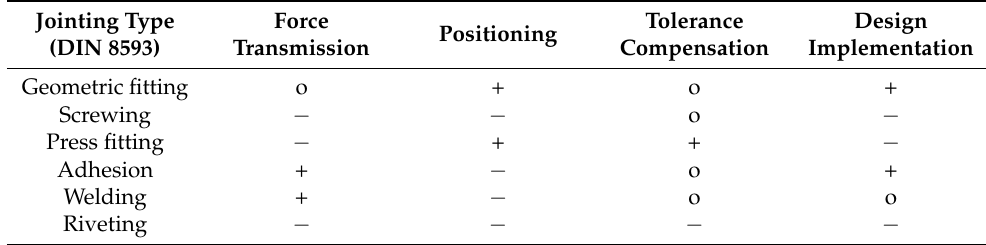
Table 2. Evaluation of different joint types in terms of the given task (o = neutral, + = advantageous, − = disadvantageous regarding the other types of